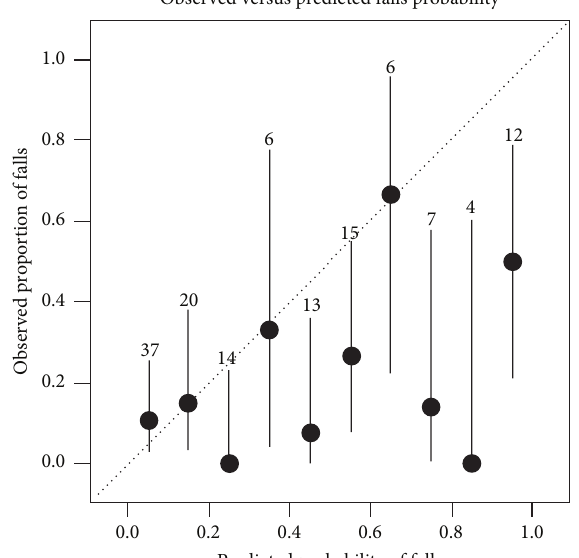
Observed versus predicted falls probability